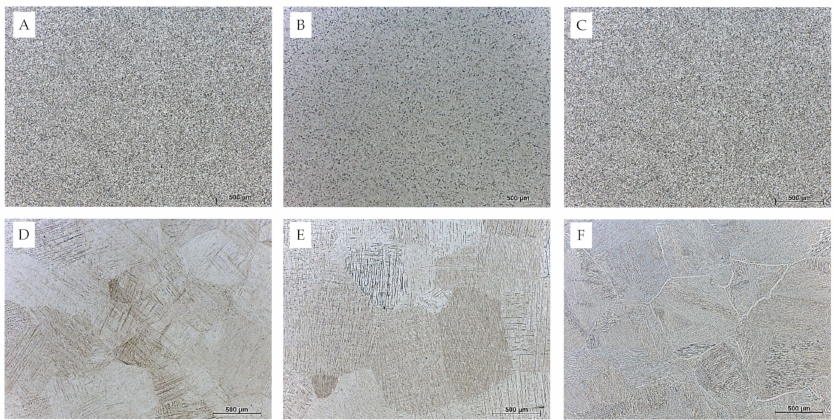
Figure A1. Optical micrographs show the macroscopic microstructures of different TiAl6V4 alloy treatments. Fine-grained conditions are present in the ( A ) wrought alloy, ( B ) A 600 and ( C ) STQ 900 samples, whereas coarse grains with intergranular substructures are present in the samples ( D ) STQ 1100, ( E ) STA 1100 and ( F ) β